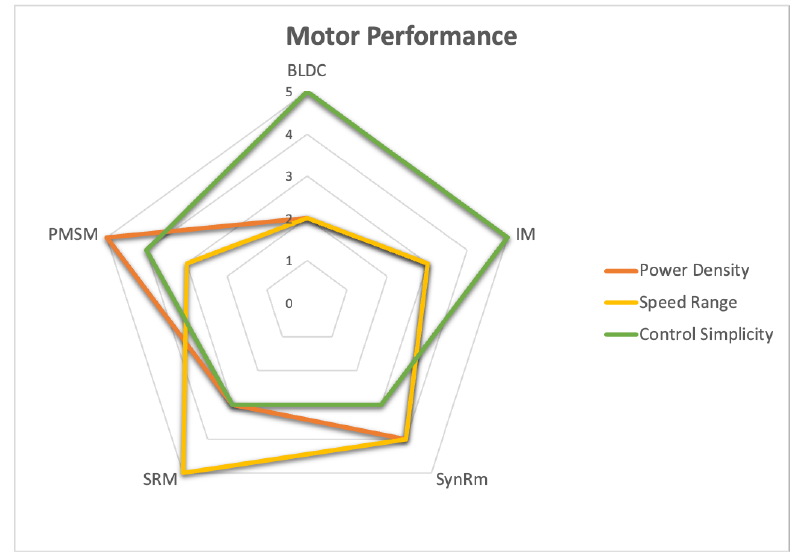
Figure 16. Performance analysis of studied motors based on speed, power and control.